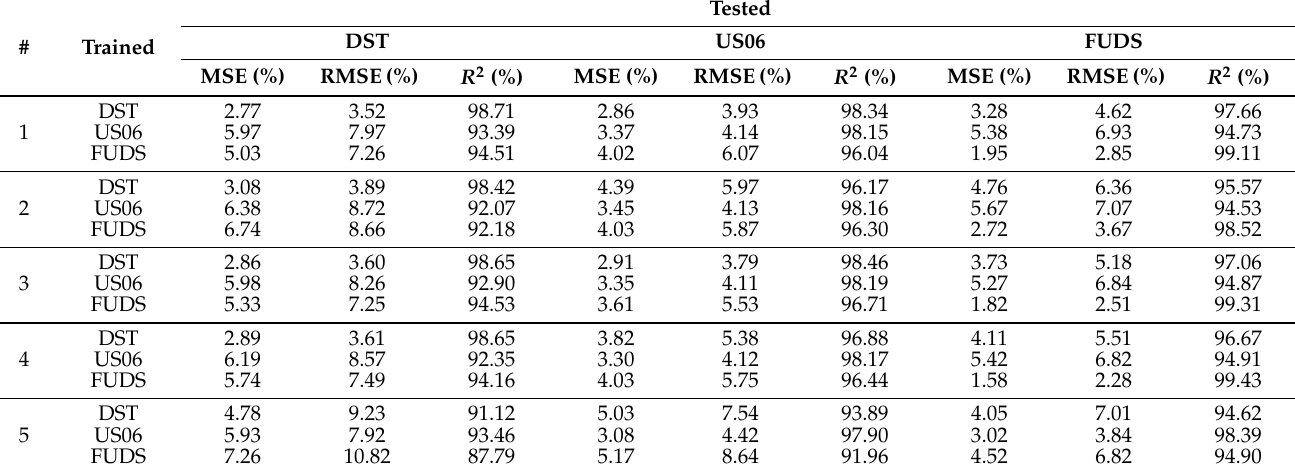
Table 8. Accuracy results summary for entire training